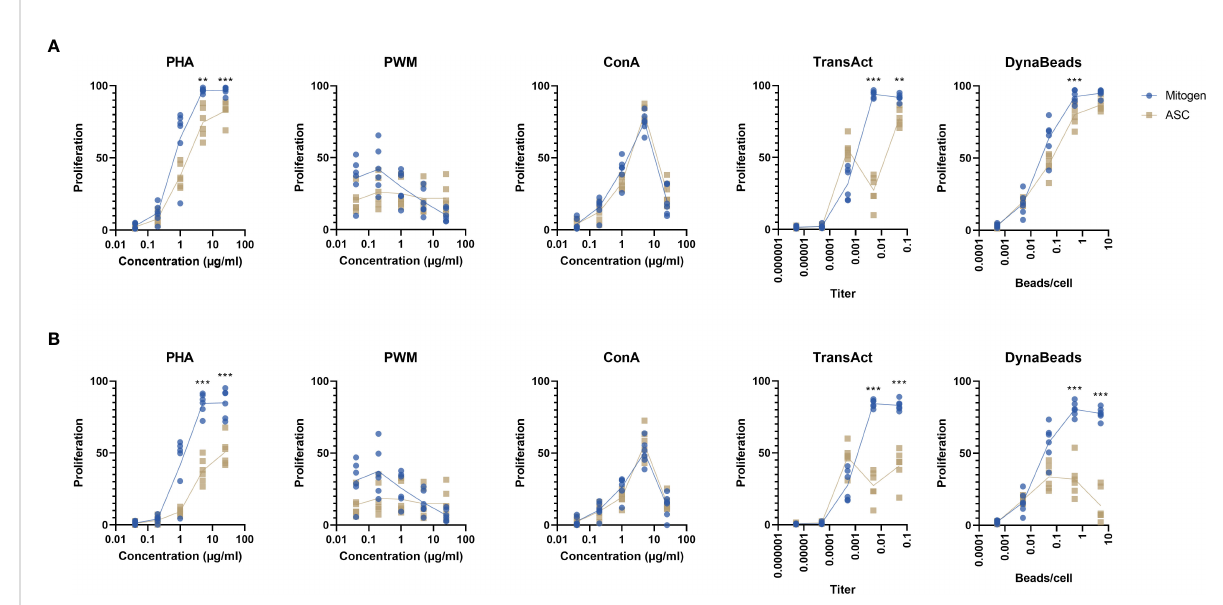
FIGURE 2 Percentage of proliferating lymphocytes by two different gating strategies. (A) The proliferation of all T cells, regardless of generation in response to 5 different mitogens at different concentration in absence or presence of ASC (blue and yellow dots, respectively). (B) The >G2 gating strategy was applied to determine T cell proliferation beyond the second generation. Paired t test. Signi fi cance levels of **) p < 0.01; and ***) p < 0.001. n=6. PHA, Phytohemagglutinin; PWM, Pokeweed mitogen; ConA, Concanavalin A; ASC, Adipose tissue-derived Stromal